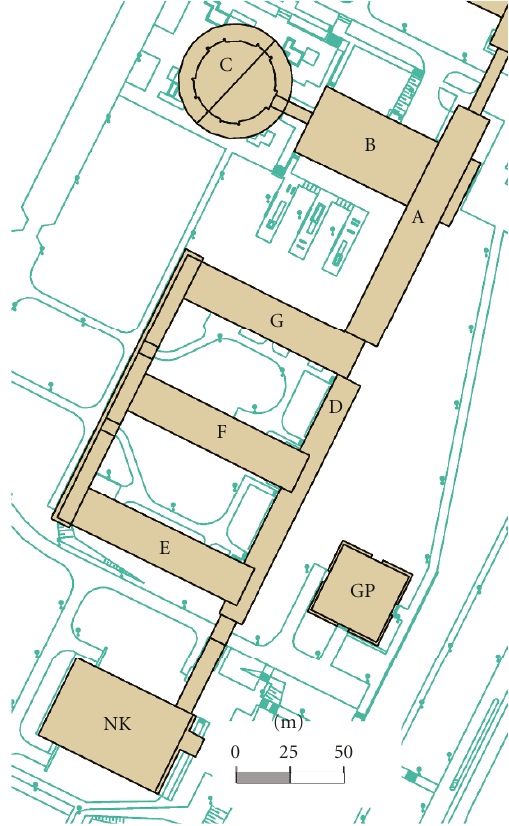
Figure 9: VSB Technical University of Ostrava—University Cam- pus